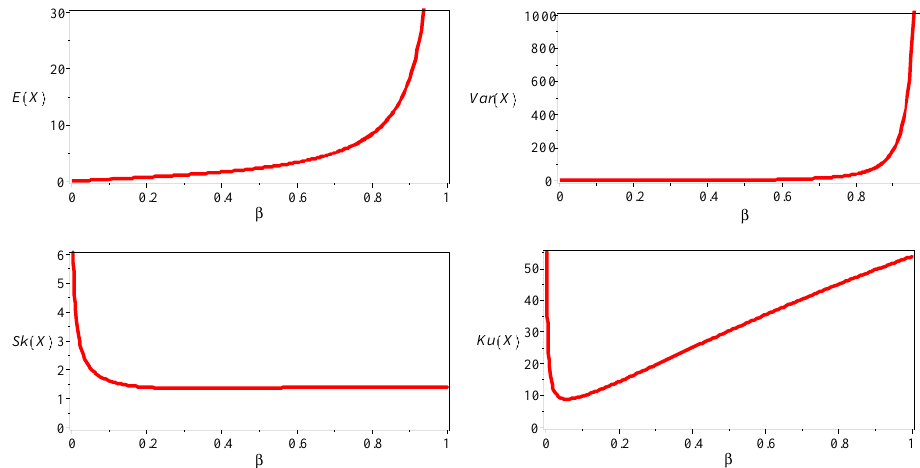
Figure 3 . The plots of descriptive measures of the DMEx distribution. Figure 3. The plots of descriptive measures of the DMEx